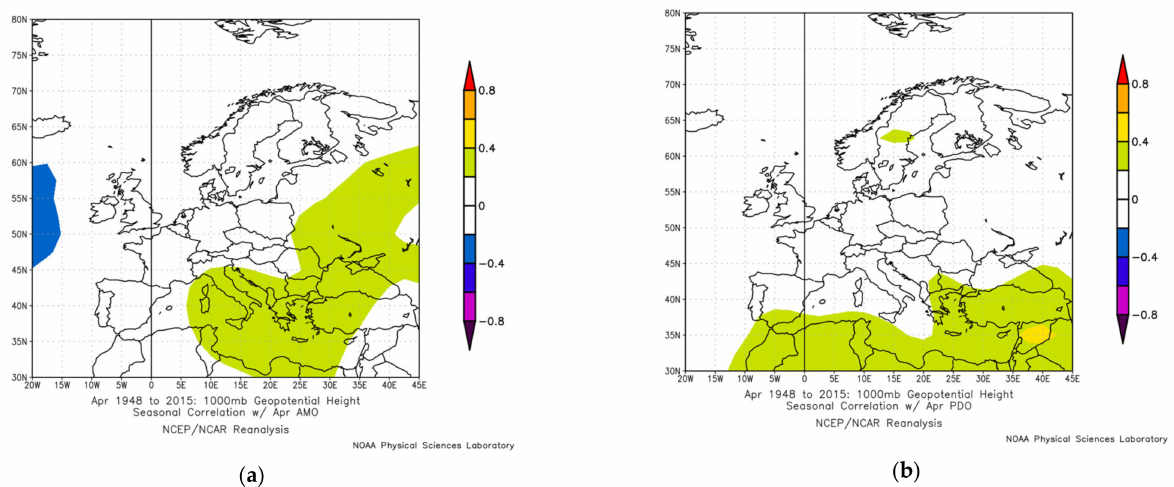
Figure 8. April correlations of the 1000 hPa geopotential height with the ( a ) AMO and ( b ) PDO indices. Correlation coefficients r < − 0.2 and r > +0.2 are significant at the 90% confidence